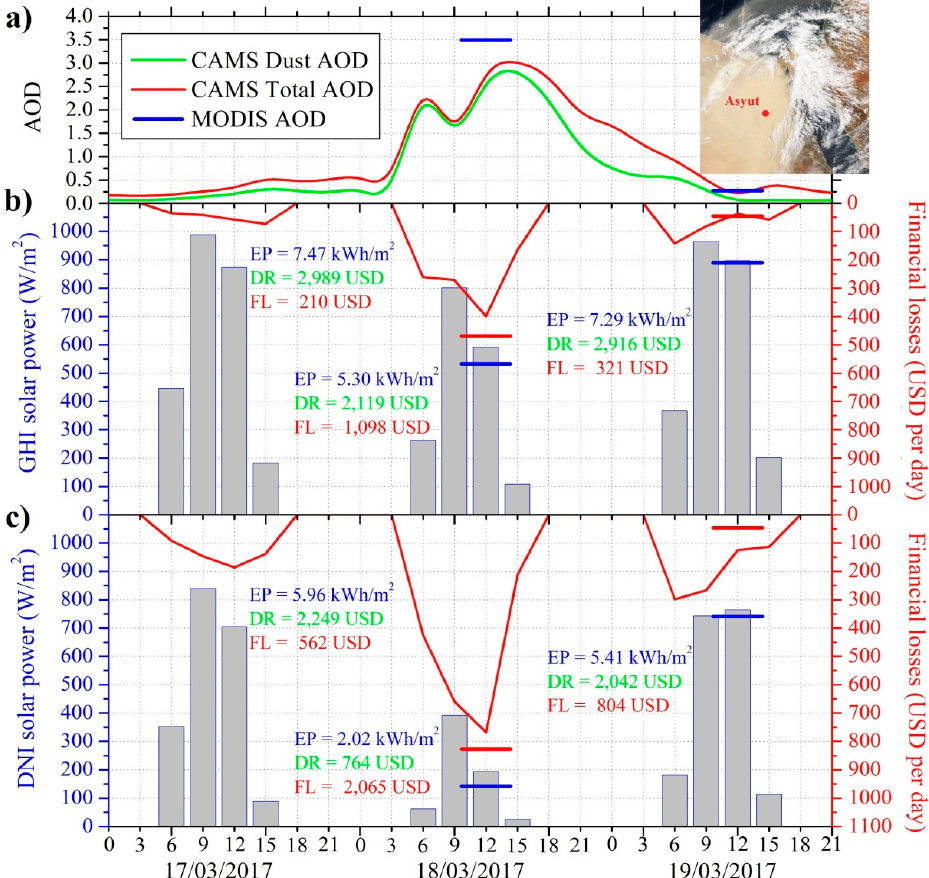
Figure 11. Temporal evolution and financial analysis of an extreme dust event impact (18 March 2017) on the CAMS AOD forecasted values ( a ) and on the produced solar energy from PV ( b ) and CSP ( c ) installations with nominal power of 10 MW in the region of ASY. The impact was quantified in terms of EP, DR and total FL. The blue and red insets show the corresponding solar power and financial losses respectively, using as input the MODIS observations.